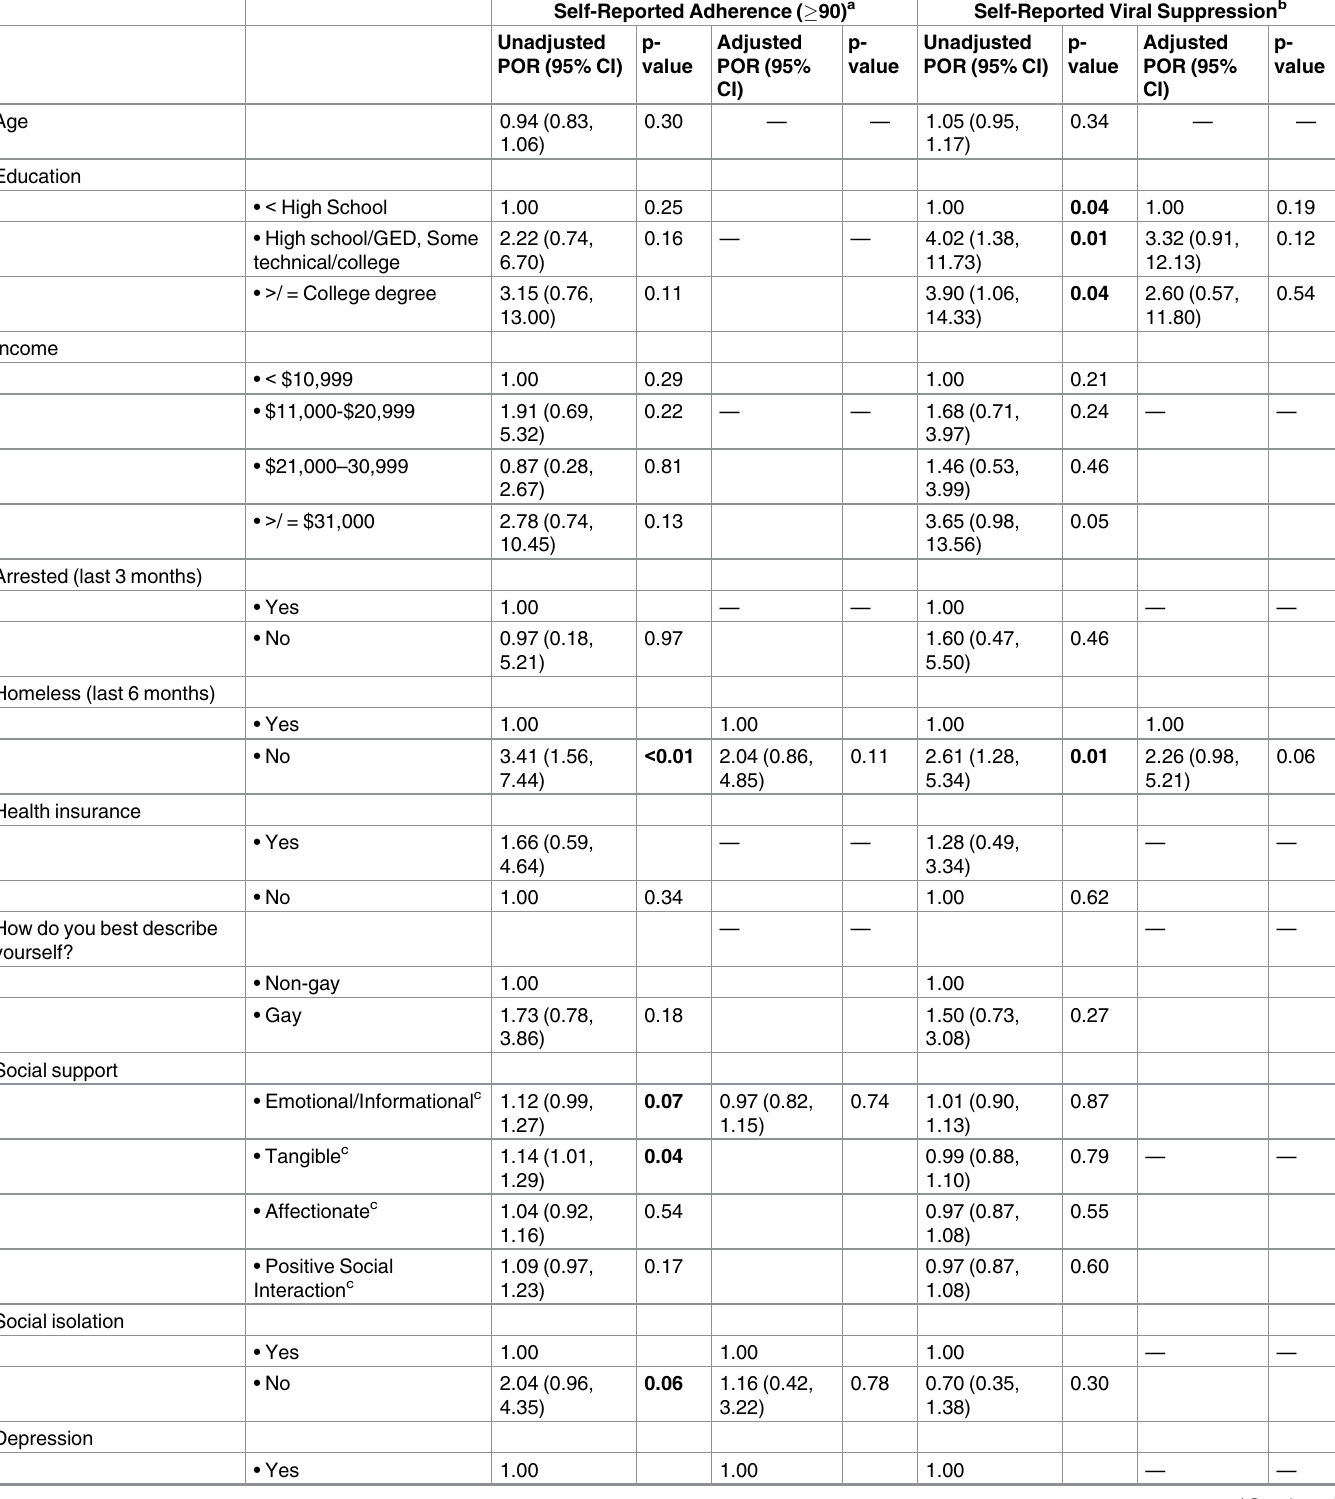
Table 4. Bivariable and multivariable analysis for self-reported antiretroviral adherence and viral